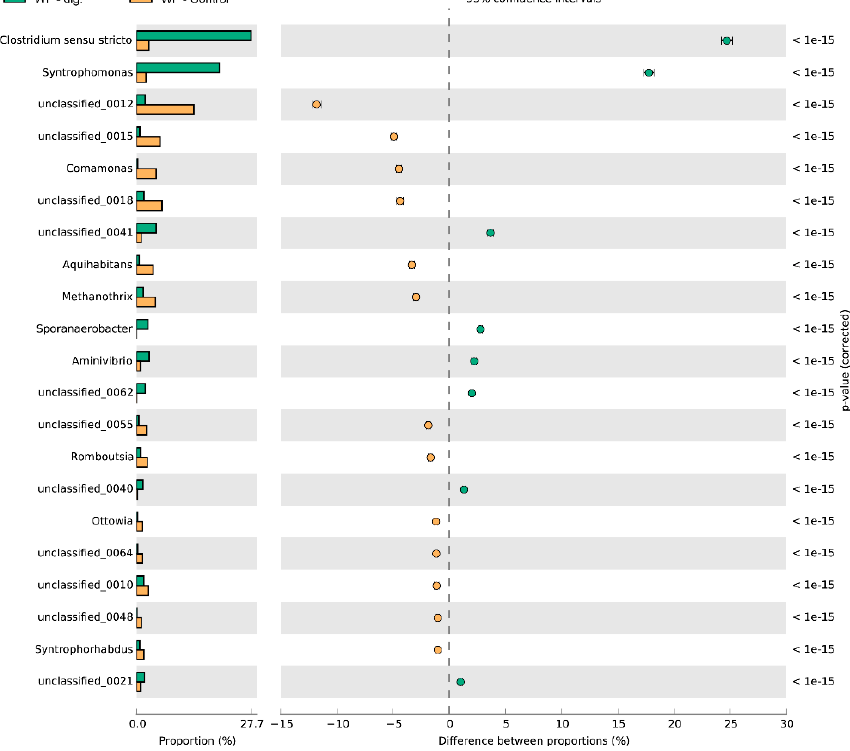
Figure 7. Comparison of bacteria genus composition between WF + control and WF + dig. variants.